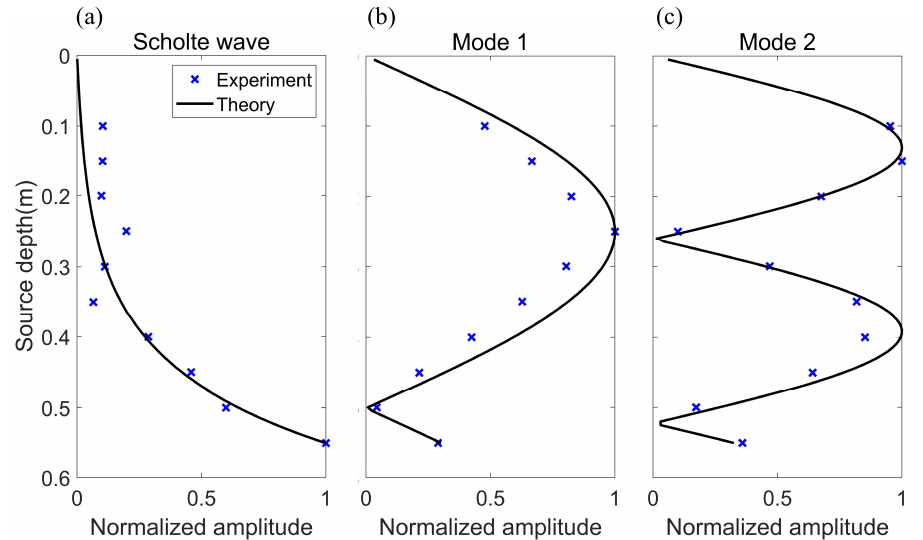
Figure 10. Mode amplitude versus source depth for the Scholte wave and normal modes (thickness of sediment is 1 mm, source frequency f = 50 kHz). The blue cross is the experimental result, and the black line is the theoretical result (mode shape function). ( a ) Scholte wave. ( b ) Mode 1. ( c ) Mode 2.